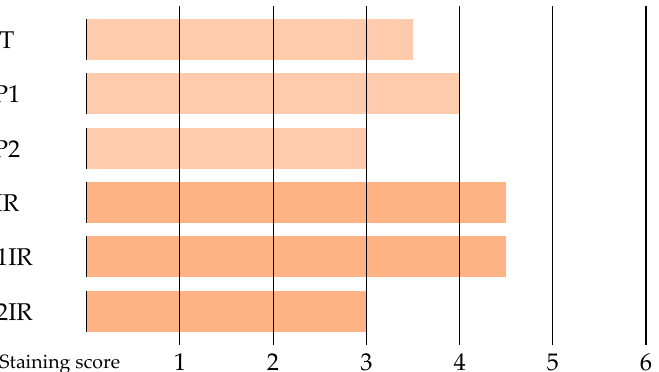
Figure 9. Scoring of the MMP-1 (Matrix Metalloproteinase 1) immunostaining by micro-